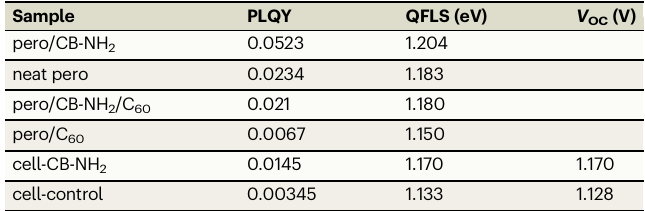
Table 1 | PLQY and QFLS results of perovskite fi lm,perovskite/ C 60 half stack, and full cell with/without CB-NH